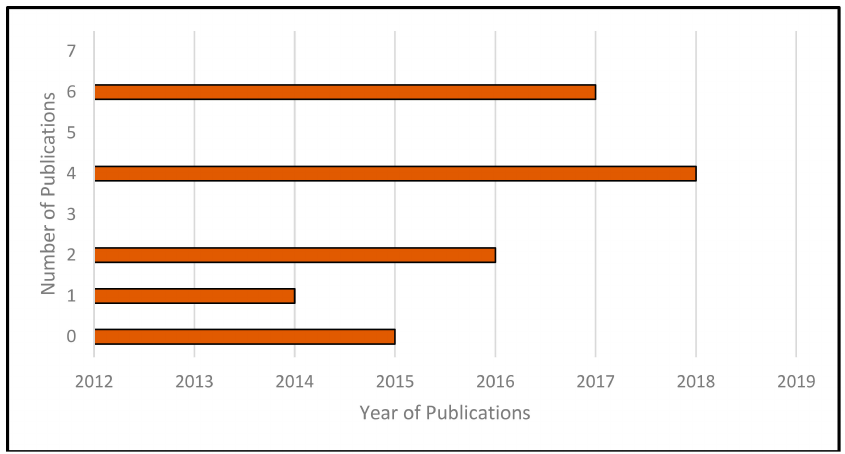
Figure 6. Number of Publications vs. Year of Publications for circular economy and Industry 4.0.